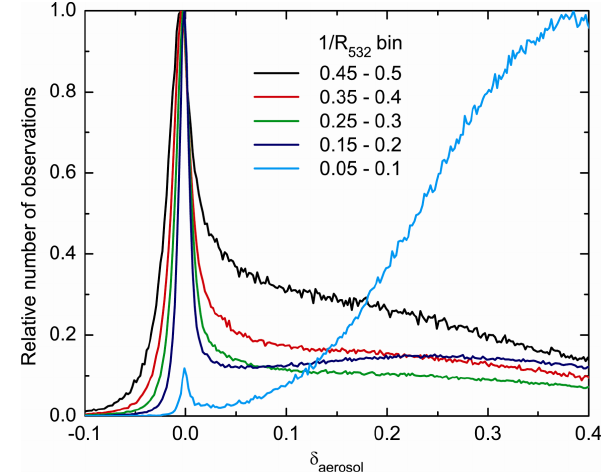
Figure 8. Normalized CALIPSO PSC aerosol probability distributions functions (PDFs) for a series of 1/R 532 bins. Fig. 8. Normalized CALIPSO PSC δ aerosol probability distributions functions (PDFs) for a series of 1/R 532